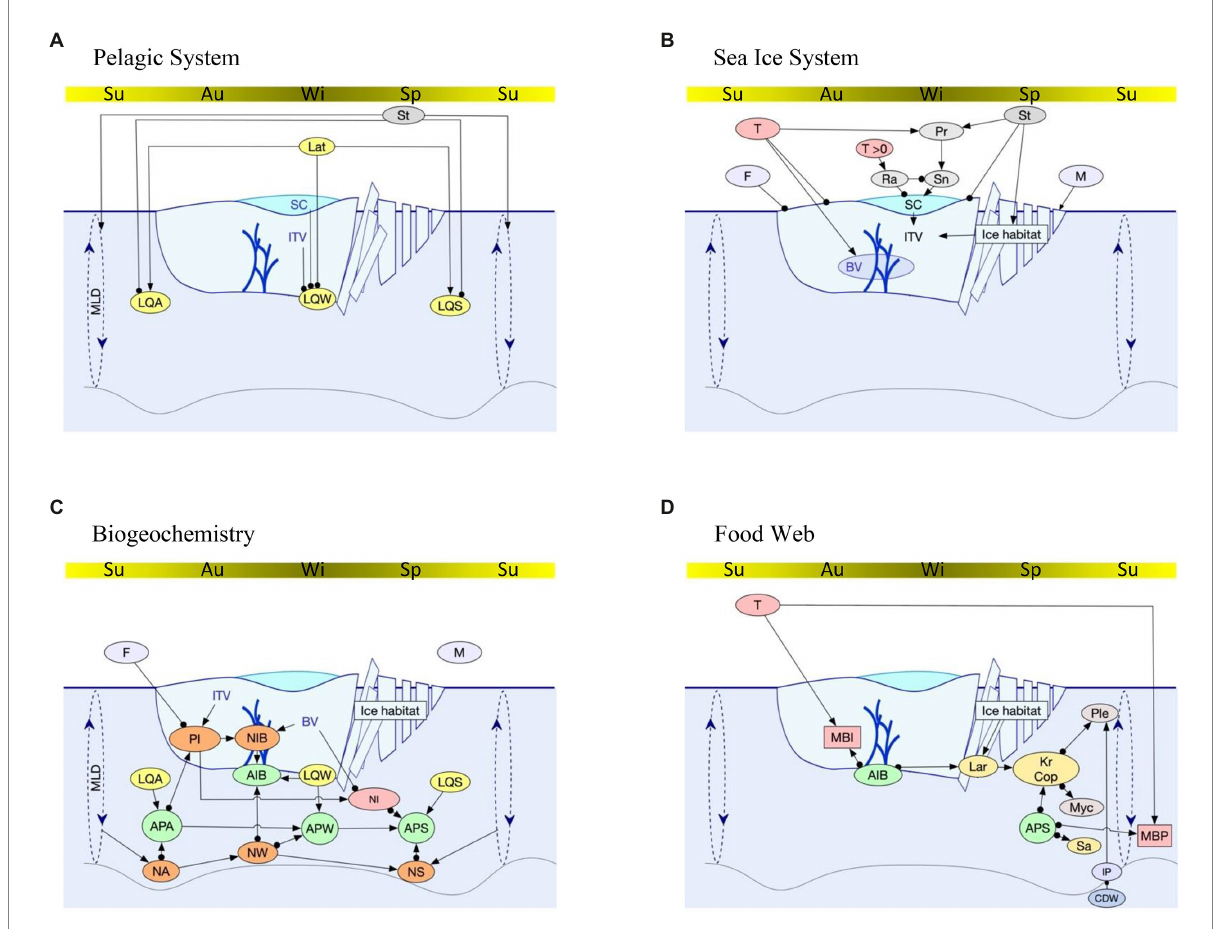
FIGURE 3 Nodes and linkages (edges) used in the qualitative network model. Each panel represents a part of the overall sea ice system. Top bar on a panel represents annual seasonal sea ice cycle from summer, autumn, winter, spring, summer. The remainder of a panel from top to bottom represents atmosphere, sea ice and pelagic realm with the bottom line indicating the bottom of the mixed layer. Cumulative symbols are as follows (Explanations in Table 2): (A) Pelagic system: Lat = Latitude; SC = Snow cover; ITV = Ice total volume; MLD = Mixed layer depth; LQA/LQW/ LQS = Photosynthetically active radiation in autumn, winter, spring. (B) Sea ice system: T = Temperature; T > 0 is air temperatures >0 ° C. St = Storms; Pr = Precipitation; Ra = Rain; Sn = snow; F = Freezing; M = Melting; BV = Brine volume. (C) Biogeochemistry: PI = Particulates taken up into ice; NIB = Nutrients in sea ice brine; AIB = Algae at lower sea ice boundary; APA/APW/APS = algae in pelagic waters in autumn, winter, spring; NI = Nutrients from melting sea ice; NA/NW/NS = Nutrients in pelagic water in autumn, winter, spring. (D) Food web: MBI/MBP = Biological metabolism in sea ice, pelagic; CDW = Circumpolar Deep Water; IP = Platelet Ice; Lar = Larvae; Kr = Antarctic Krill; Cop = Copepods; Ple = Pleuragramma; Myc = Myctophids; Sa =